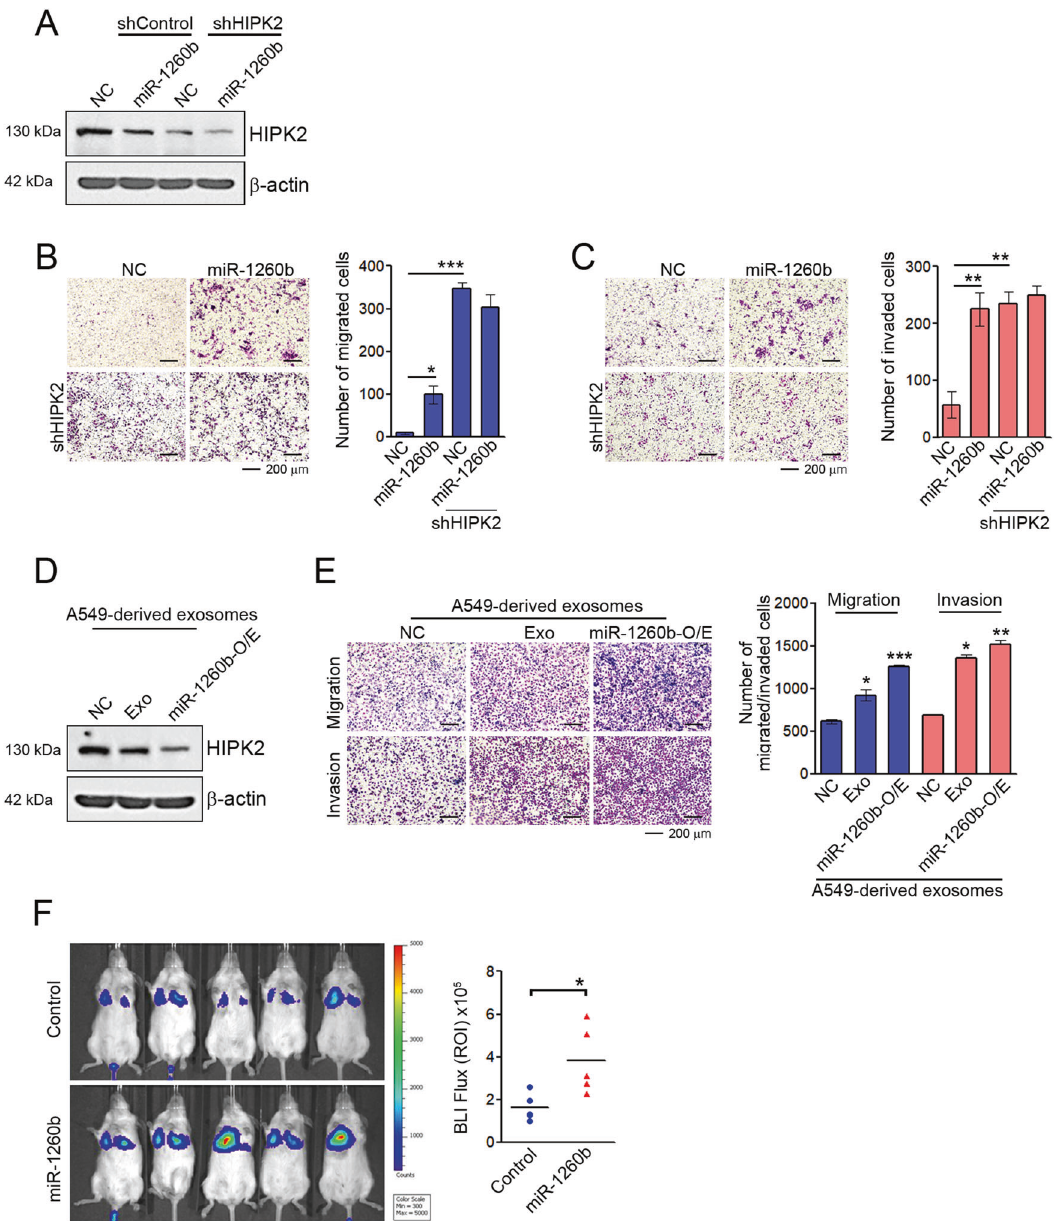
Fig. 2 Effects of exosomal miR-1260b on migration and invasion of NSCLC. A – C A549 cells were transfected with 50 nM control miRNA (NC) or miR-1260b mimic for 48 h following infection of lentiviral shcontrol or shHIPK2. A HIPK2 expression was con fi rmed by western blotting. B , C Transwell assays were performed to detect changes in migration and invasion abilities. The number of migratory or invading cells was counted for each image fi eld. D , E PC-9 cells were treated with 50 μ g of exosomes derived from A549 and their stable cell lines (miR-1260b-O/E or anti-miR-1260b-O/E). HIPK2 expression was con fi rmed by western blotting, and the ability of migration and invasion was determined using Transwell assays. Data are reported as the mean ± standard deviation of three independent experiments with fi ve fi elds counted per experiment. F IVIS luciferase in vivo images of lung metastasis. Lung metastasis models by using A549 cells were established as described in “ Materials and methods. ” Luciferase activities were determined by bioluminescent imaging (BLI) at 2 weeks after injection of the indicated cells. * P < 0.05, ** P < 0.005, *** P < 0.0005 compared with the control